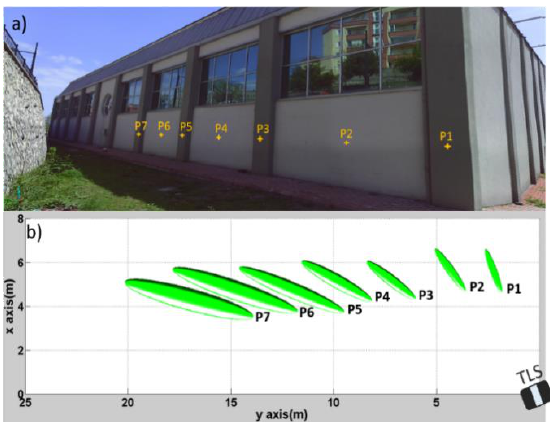
Figure 9. A building section with varying sensor-to-object distance and incidence angle. Seven points P1 to P7 selected on the object surface (a), and their associated point error ellipsoids,